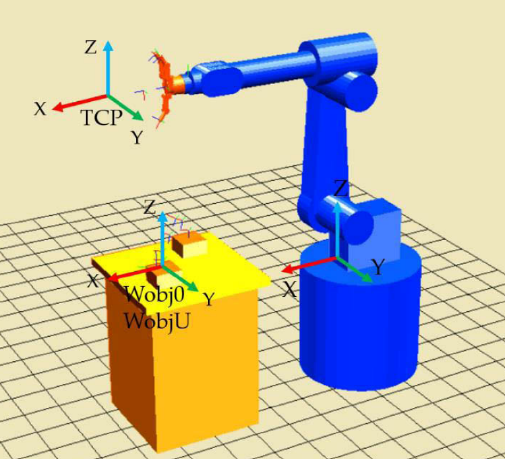
Figure 7. Main frames of the hand + arm system, simulated in Matlab.